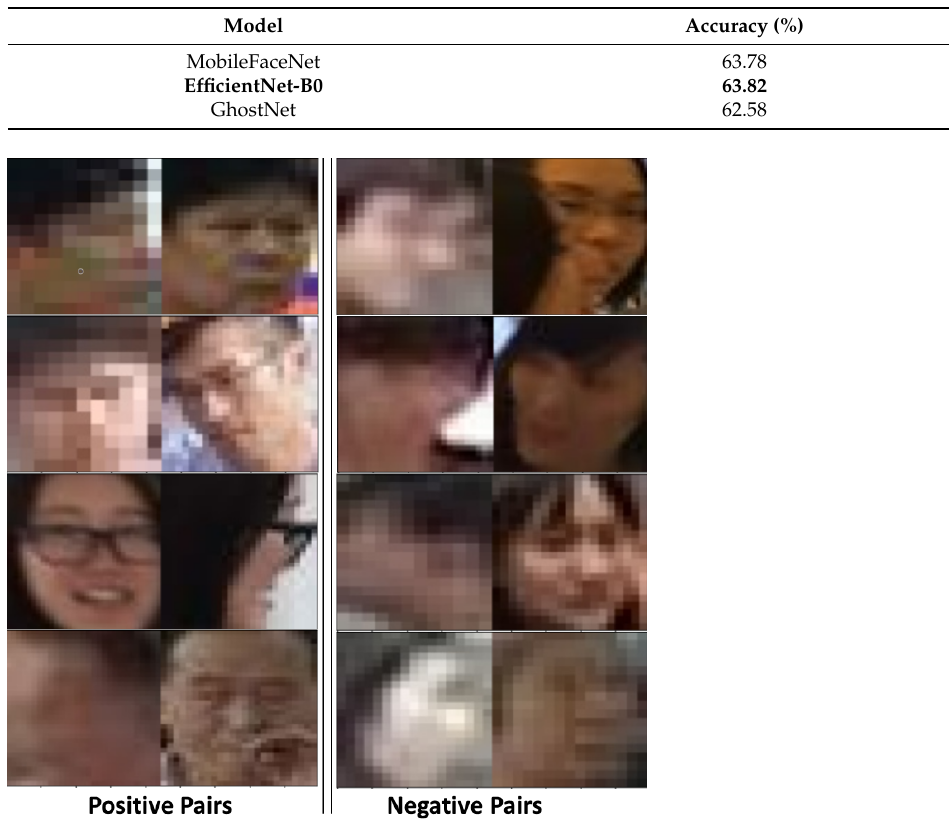
Table 7. Verification performance with the QMUL-SurvFace [14] dataset.